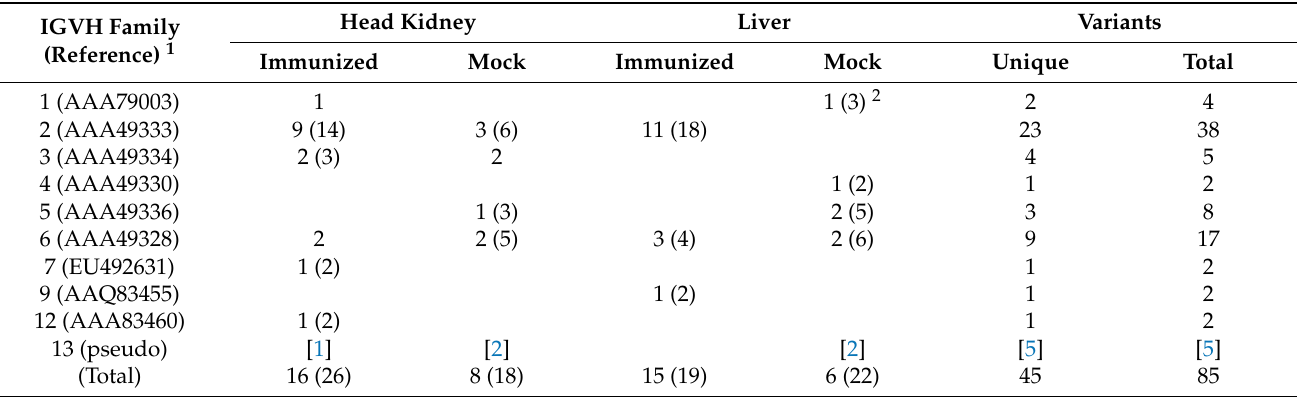
Figure 2. ( A ) Alignment of variants of IgM variable domain plus joint segment (JH). Consensus amino acids among all sequences are marked with asterisks. Three complementarity determining regions (CDR1–CDR3) are indicated (between > and <) and the diversity (D) segment is within CDR3. Sequence codes (names) beginning with 1 and 3 are those cloned from ECP-immunized head kidney and liver, respectively; and the codes beginning with 2 and 4 are those cloned from mock-immunized head kidney and live, respectively. ( B ) Diagram of overall similarity of the variable domain (VH) of 45 IGVH variants. Three frameworks (FR1–FR3), three complementarity determining regions (CDR1–CDR3), and a joint (JH) segment are shown. Similarity values range from 0–1 (1 = identical, 0.5 = similar, and 0.2 = weakly similar). Table 3. Variants of IgM heavy chain variable domain cloned from tissues of ECP-immunized and mock-immunized channel catfish and distribution in IGVH